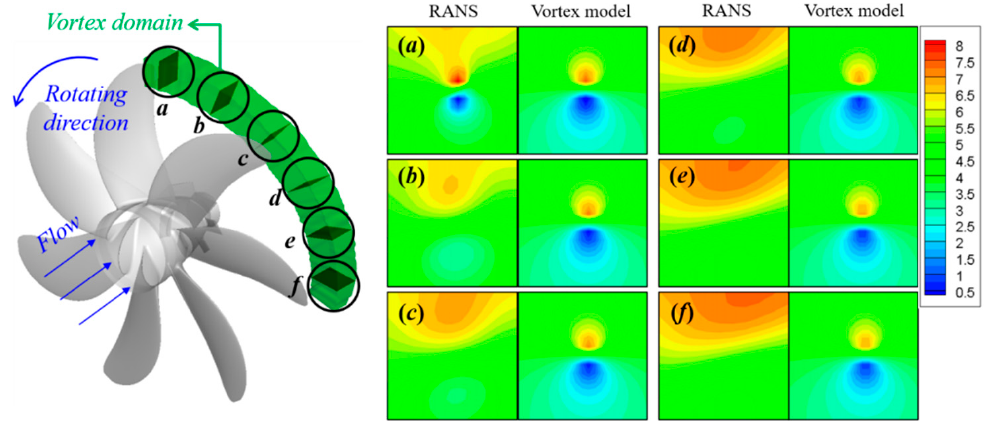
Figure 17. Comparison of distribution of axial velocity of original RANS results with those reconstructed by using the vortex model.